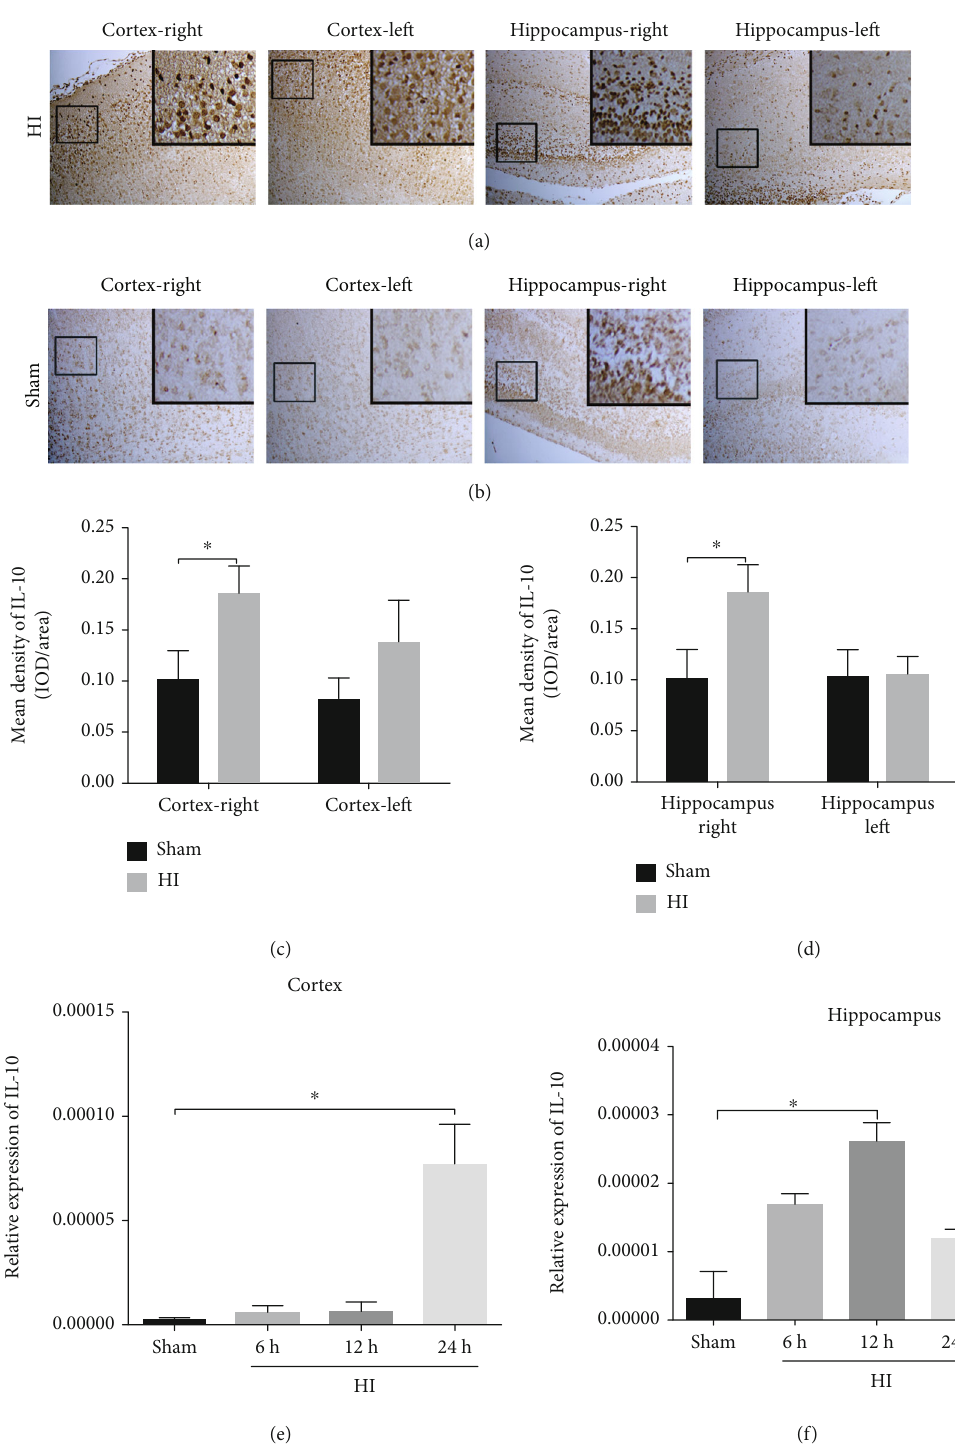
Figure 1: The expression of IL-10 in the cortex and hippocampus after HI. (a, b) Enzyme immunohistochemistry staining of the IL-10 expressed in the cortex and hippocampus sections from rats. Scale bar = 200 μ m . (c, d) The mean density of IL-10 in the right and left of the cortex and hippocampus in the sham and HI groups. (e, f) The relative mRNA expression of IL-10 in the right cortex and hippocampus at 6h, 12 h, and 24 h after HI. HI: hypoxia-ischemia; IL-10: interleukin 10; h: hour. The data were represented as mean ± SD n = 6 /group, ∗ P < 0 : 05